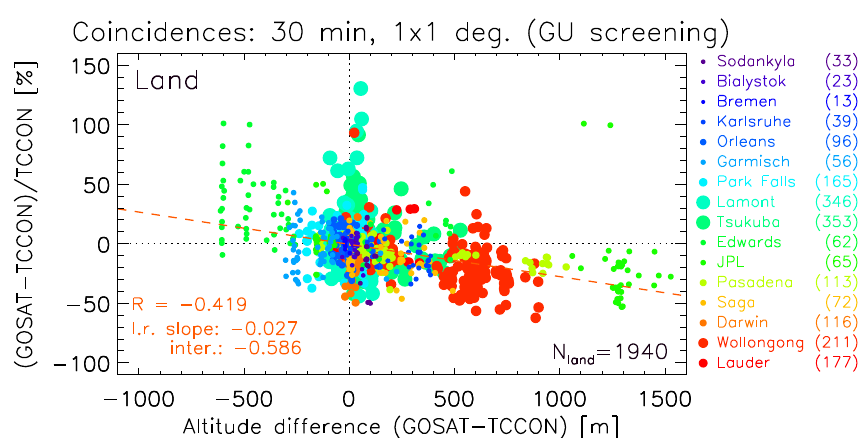
Figure 9. Relative differences (GOSAT − TCCON)/TCCON as a function of the difference, in meters, between the retrieved altitude of the GOSAT footprints and the altitude of the TCCON sites, for GOSAT land scans only. The caption and color-coding are identical to those of Figure